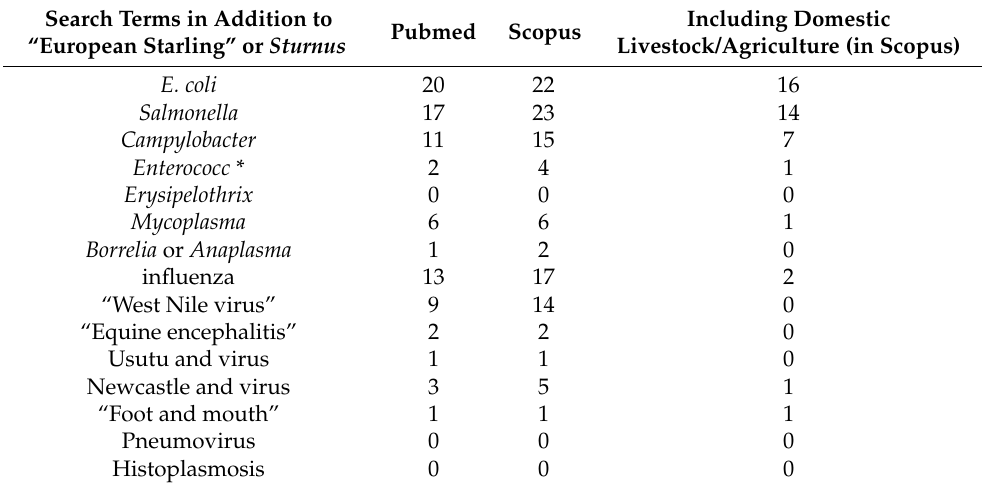
Table 1. Publications which include European starlings and bacterial, viral, and fungal diseases which impact humans and domestic livestock and are available from two scientific databases (entries of 0 in the first two columns indicate that these specific search terms yielded no results; a few publications were located through more general